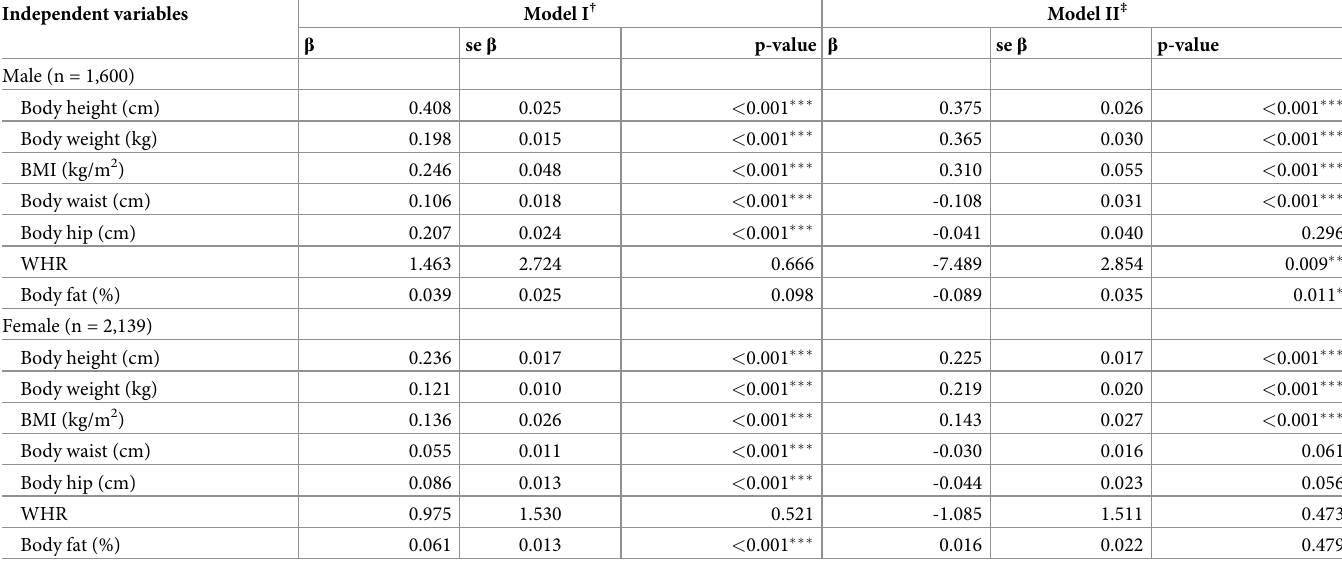
Abbreviations: β , regression coefficient; se, standard error; BMI, Body mass index; WHR: Body waist to hip ratio. † Model I: Adjusting for age, smoking, alcohol drinking, and chronic diseases status (cardiovascular disease, cerebrovascular disease, hypertension, dyslipidemia, diabetes mellitus, and chronic kidney disease). ‡ Model II: For body height, body weight, and BMI further adjusting for body waist and body hip; for body waist, body hip and WHR further adjusting for body height and body weight; for body fat further adjusting for BMI and WHR. Multivariate regression analysis for anthropometric variables on grip strength ��� p < 0.001 �� p < 0.01 � p <